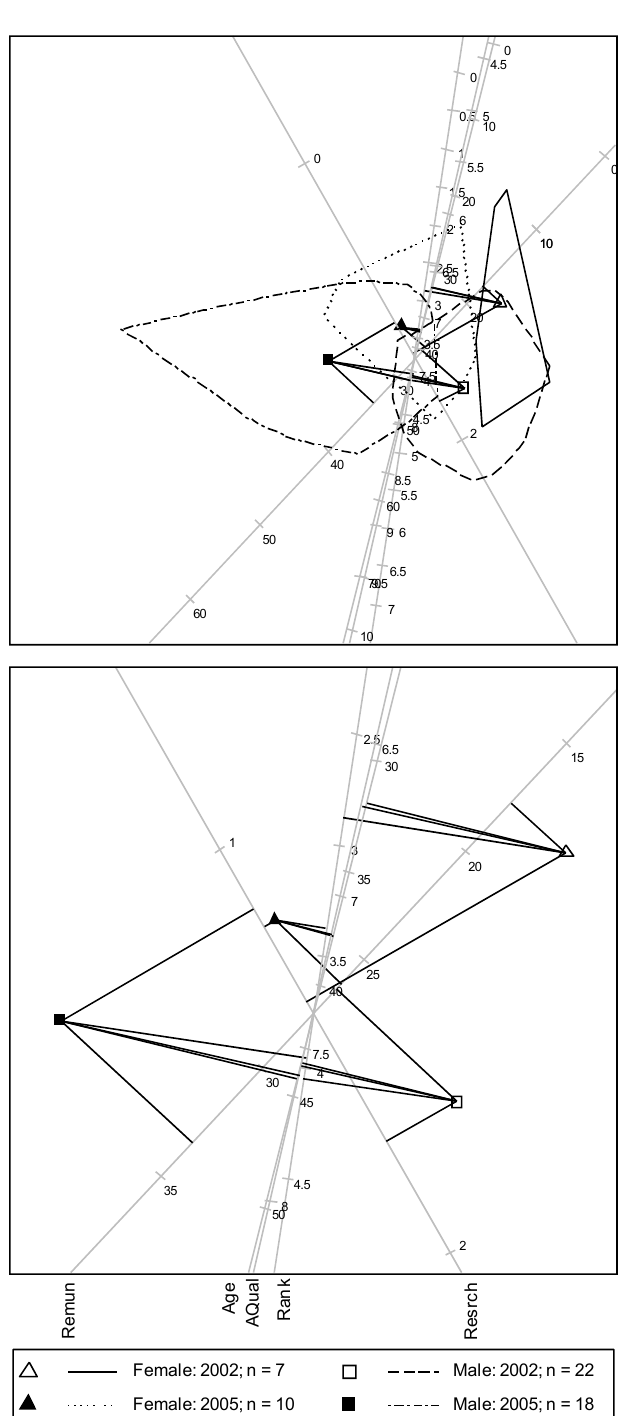
Figure 7: CVA biplot separating C1 staff in the Faculty of Law according to the 2002 Female, 2005 Female, 2002 Male and 2005 Male subgroups. Plotting of data points is suppressed. The upper panel shows the biplot overlaid with 90% bags. The bottom panel shows the group means on a large scale together with perpendicular lines from each group mean to the five axes for determining the biplot predictions of the different